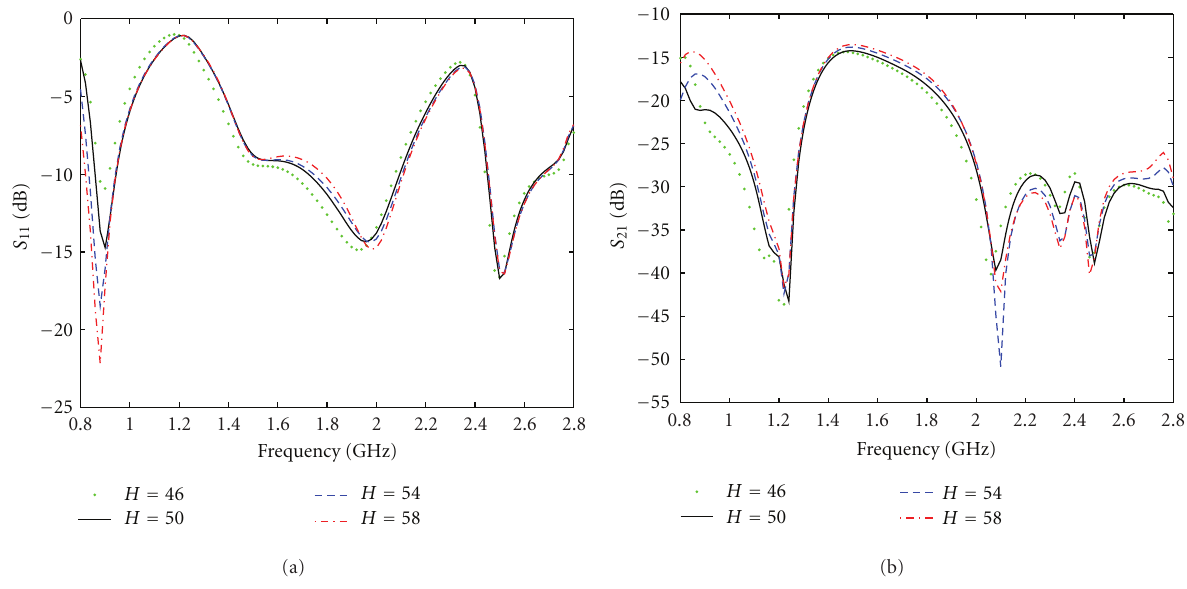
Figure 15: Simulated results of S parameters when parameter W varied (Unit: mm). (a) S 11 . (b) S 21 .